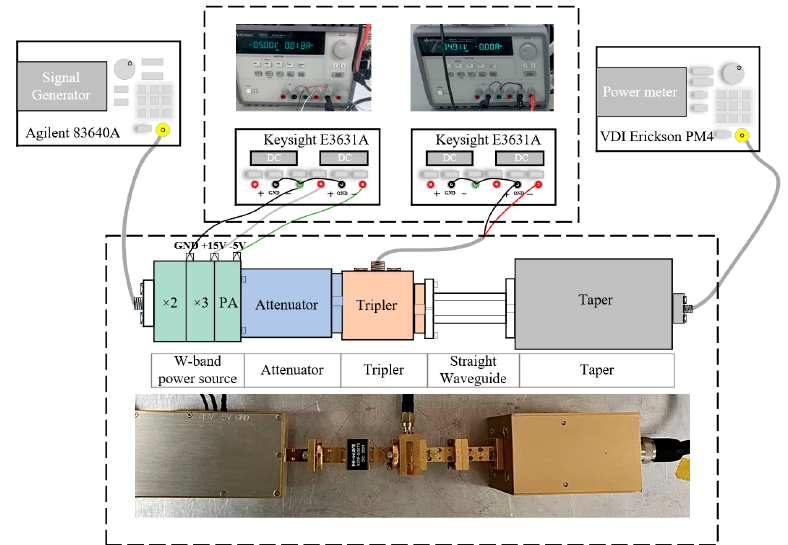
Figure 5. Block diagram of the test system.